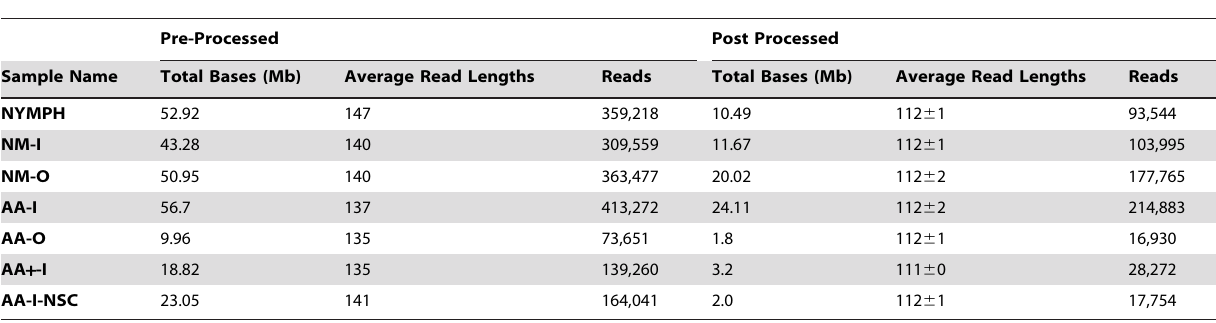
Table 2. Summary statistics of all runs on the Ion Torrent PGM.